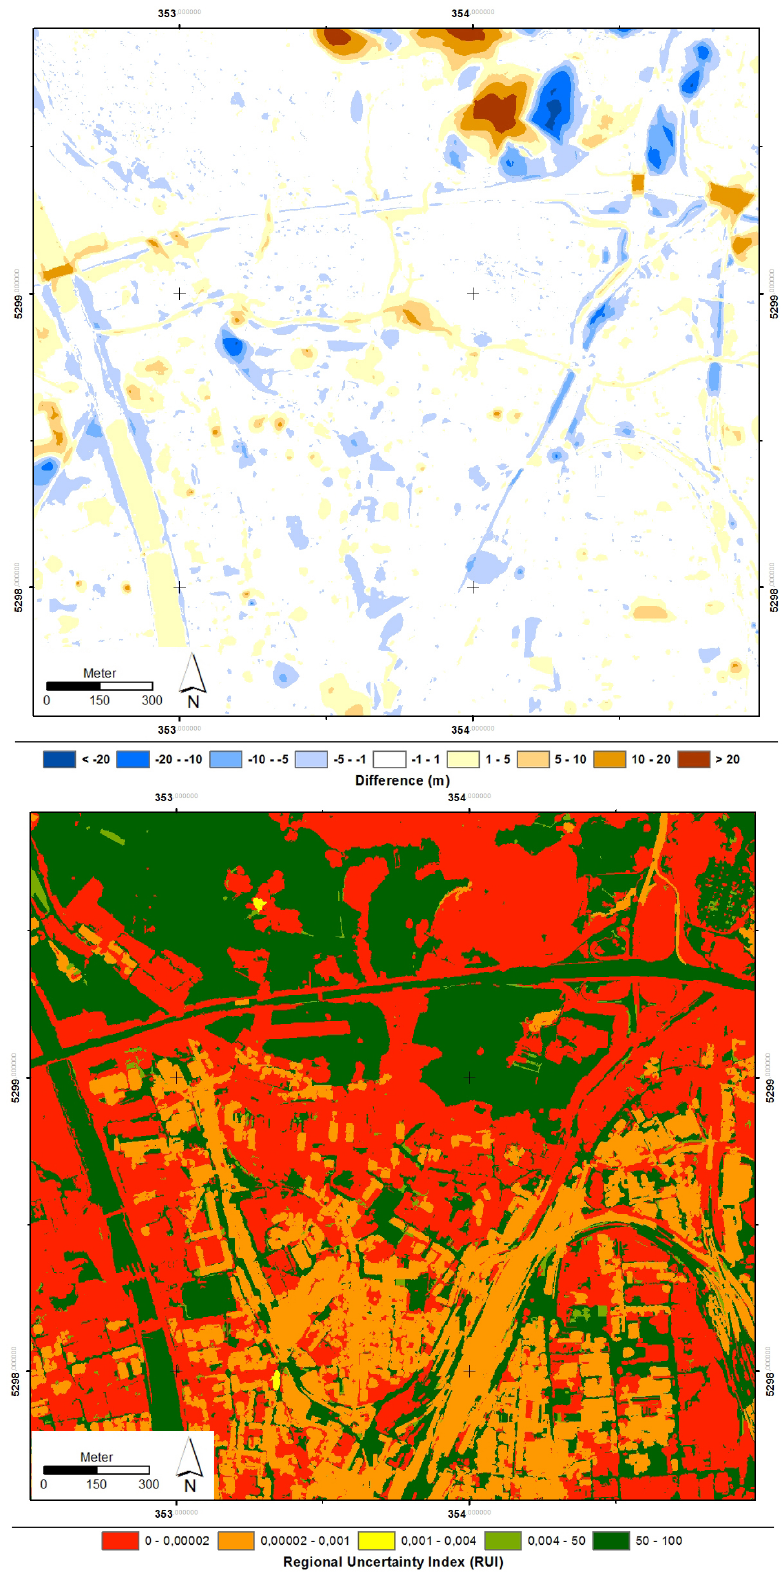
Figure 5. Top : Error map showing the height variation of the generated DEM and the reference LiDAR-DEM. Bottom : RUI classification for the study area; green values indicate a very high sampling rate, red values indicate low sampling rates per